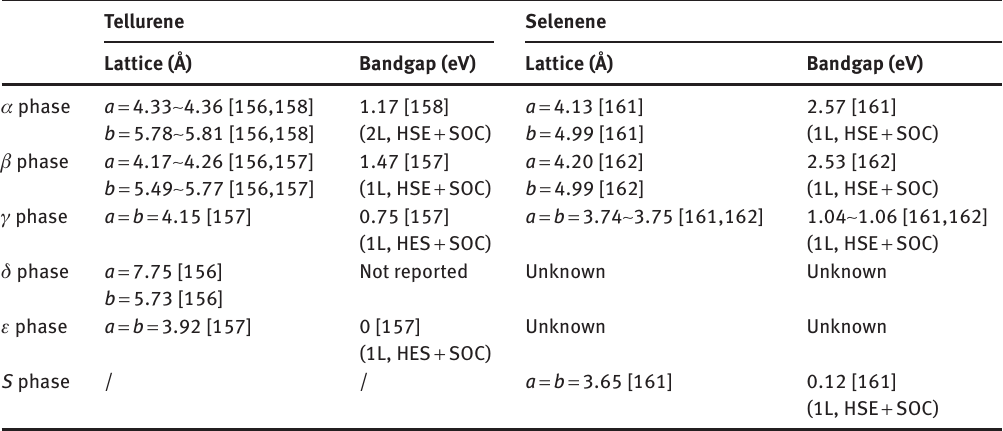
Table 1: Comparison of crystal structure of allotropes in tellurene and selenene.